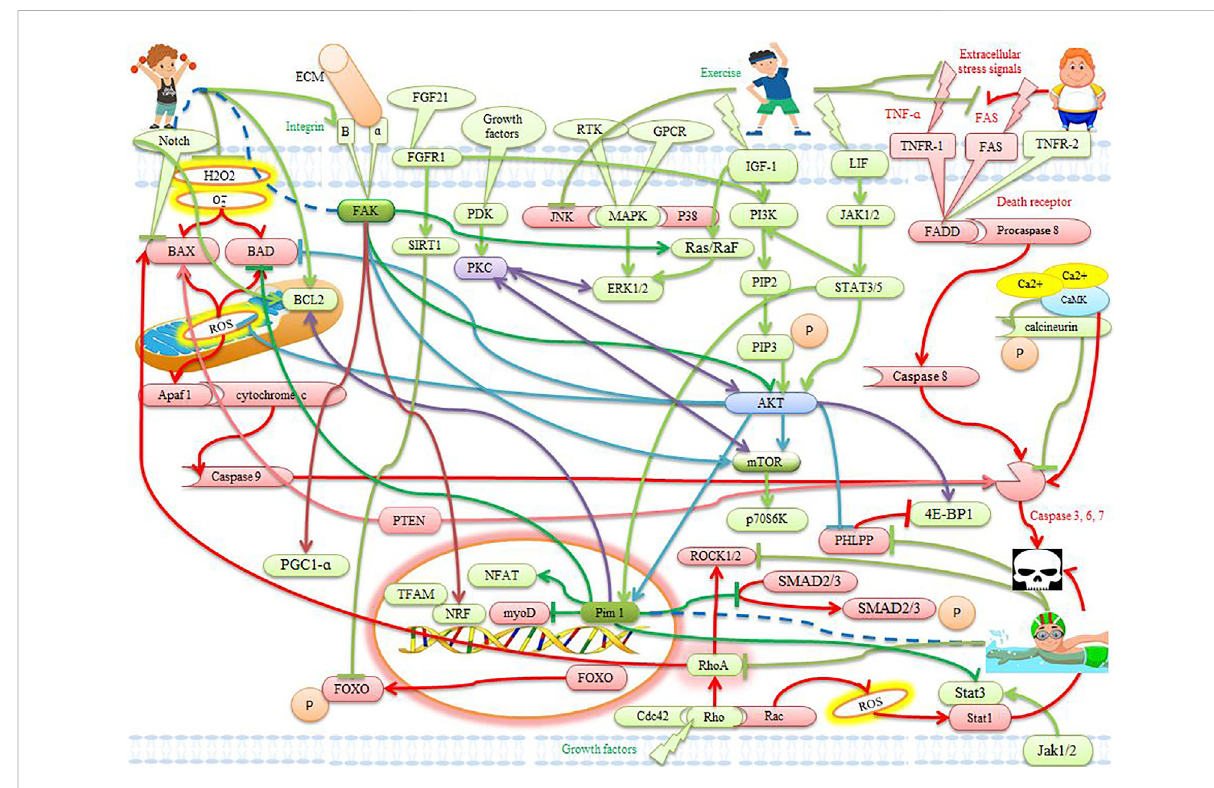
FIGURE 2 The effects of exercise on apoptotic and anti-apoptotic pathways in the heart. Description is available in the